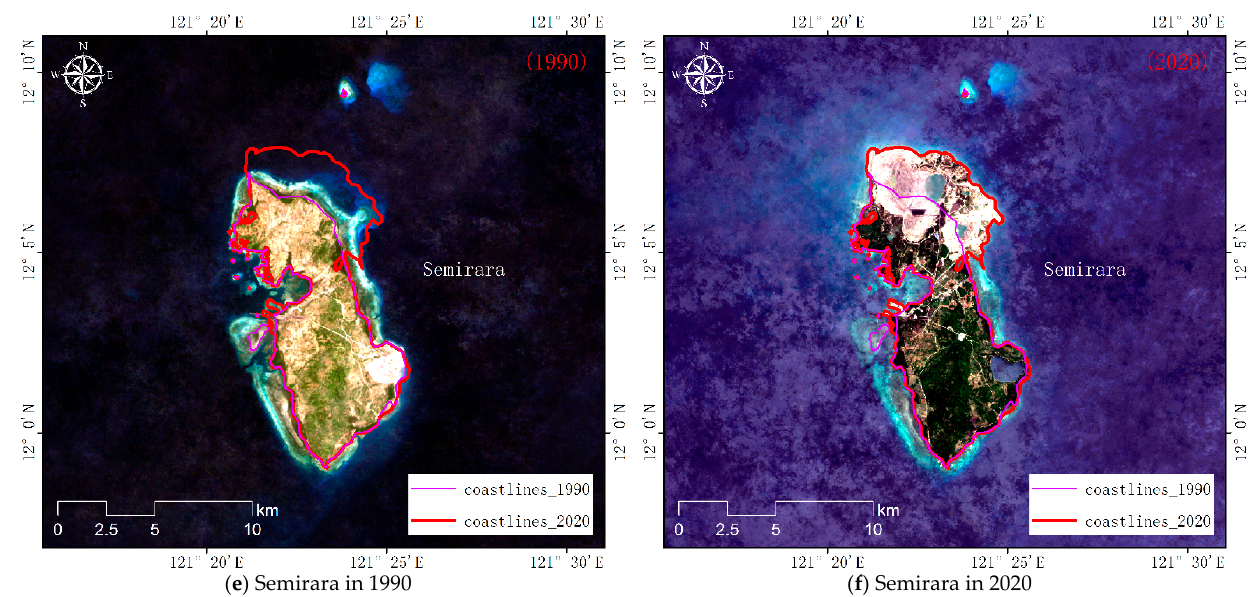
Figure 12. Typical demonstration area of artificial reconstruction.